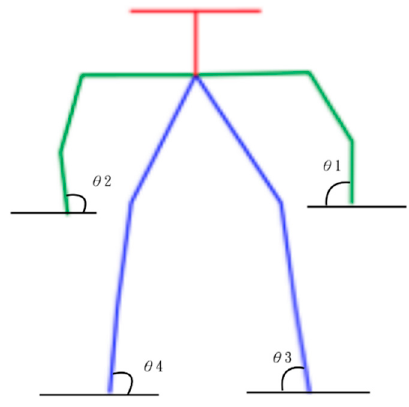
Figure 3. Four limb